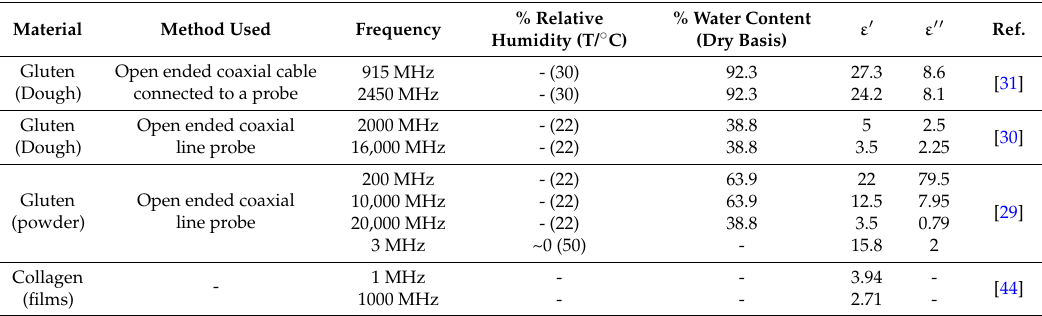
Table 2. Dielectric permittivity and loss of some proteins found in literature as a function of parameters such as frequency and water content.